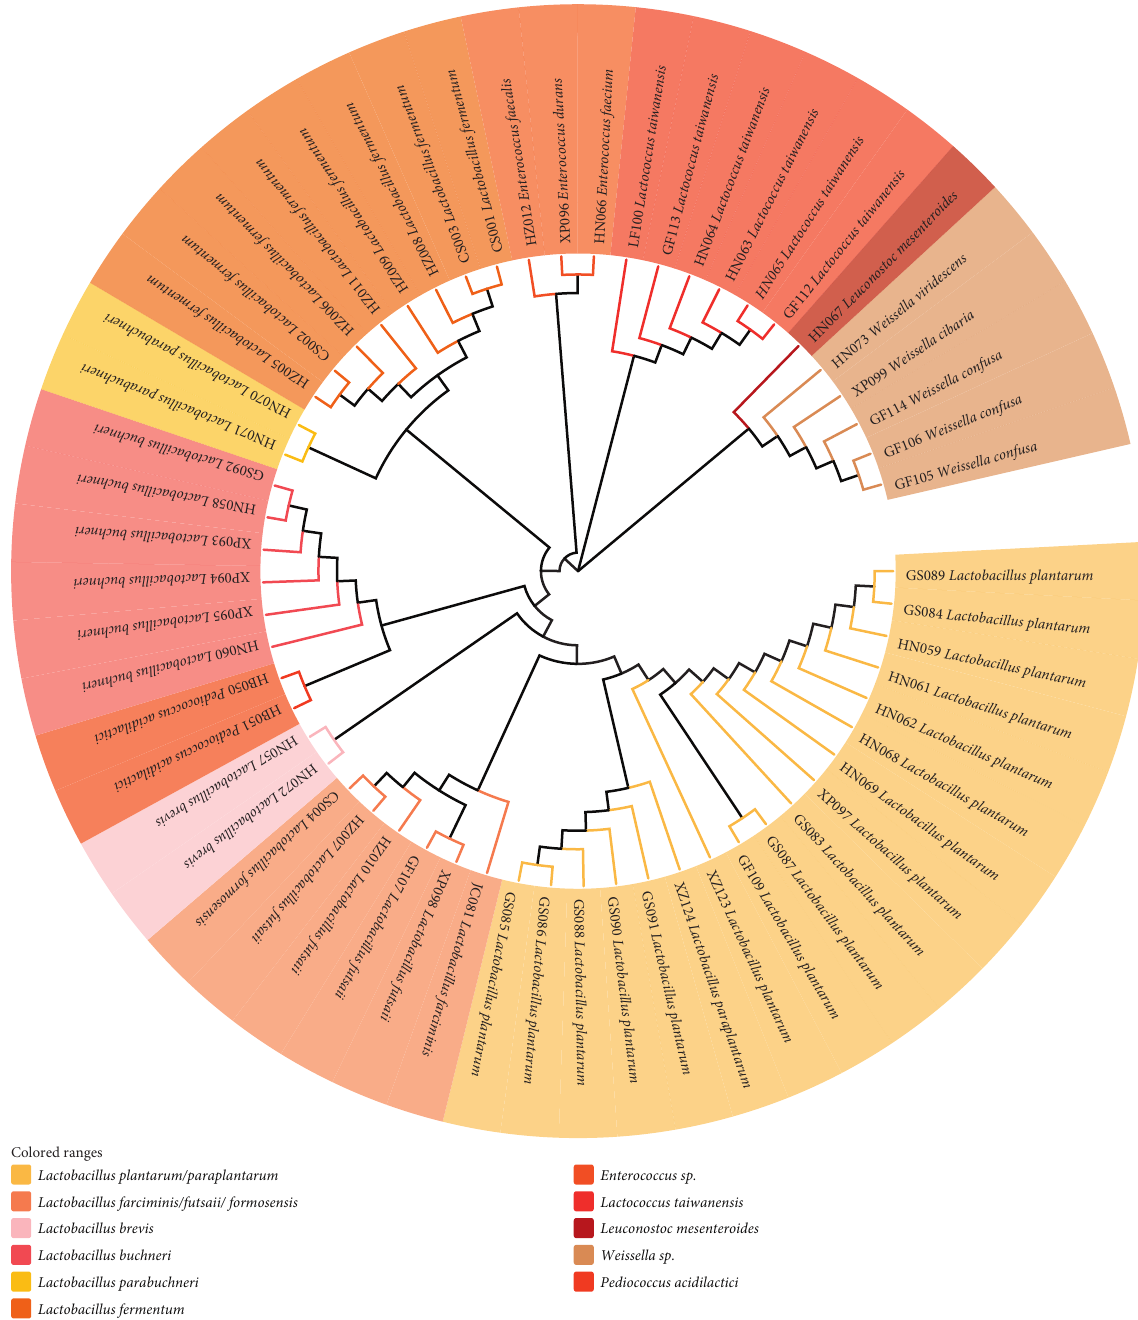
Figure 1: Circular phylogenetic tree based on the neighbor-joining method of 16S rRNA gene sequences of the isolated LAB. The scale bar represents 0.010-nucleotide substitutions per